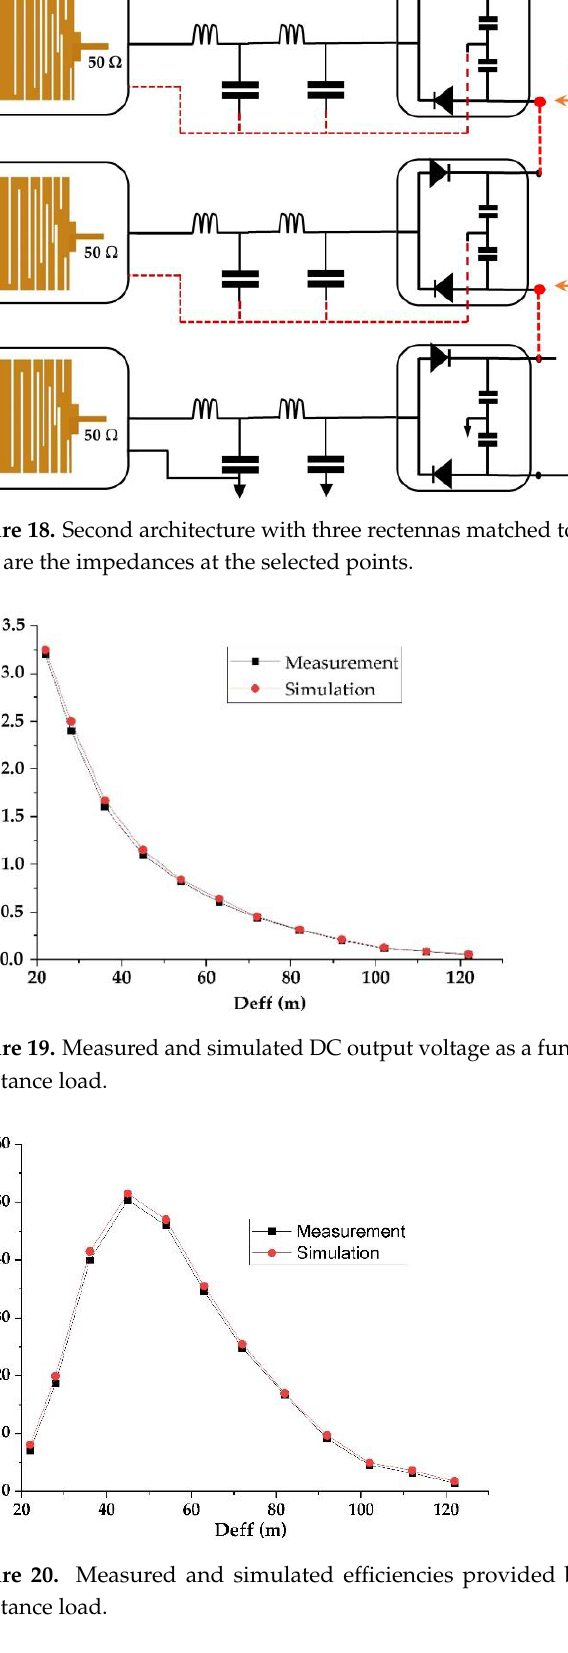
Figure 20. Measured and simulated efficiencies provided by the second architecture for 2 kΩ re- sistance load . resistance